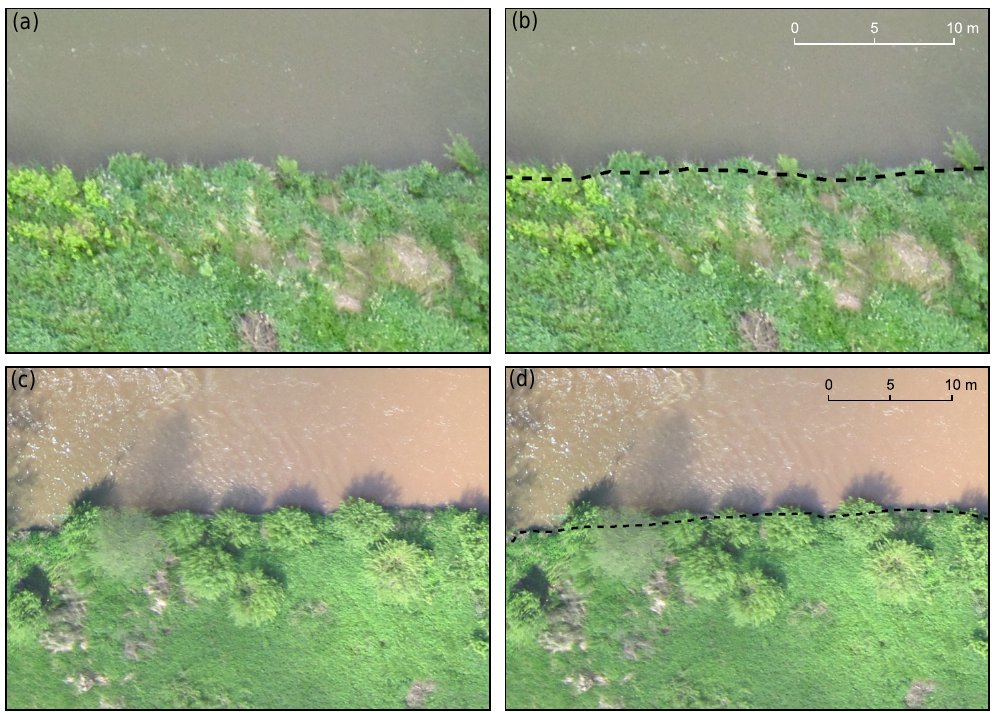
Figure 5. Determination of water surface areas: (a, b) as a line connecting the gaps between the clumps of grass on undercut river bank covered by soil-turf overhangs, (c, d) as a line interpolated between last exposed parts of riverbank at both ends of woodlots or